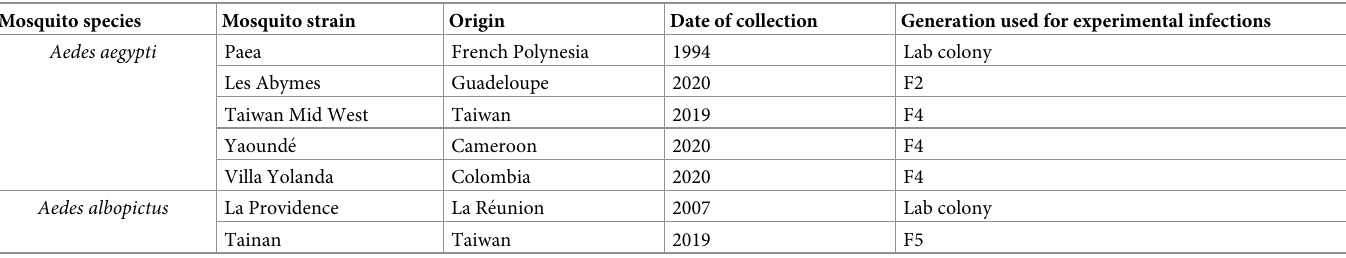
Table 1. List of mosquito colonies/populations used for YFV infections. Mosquito